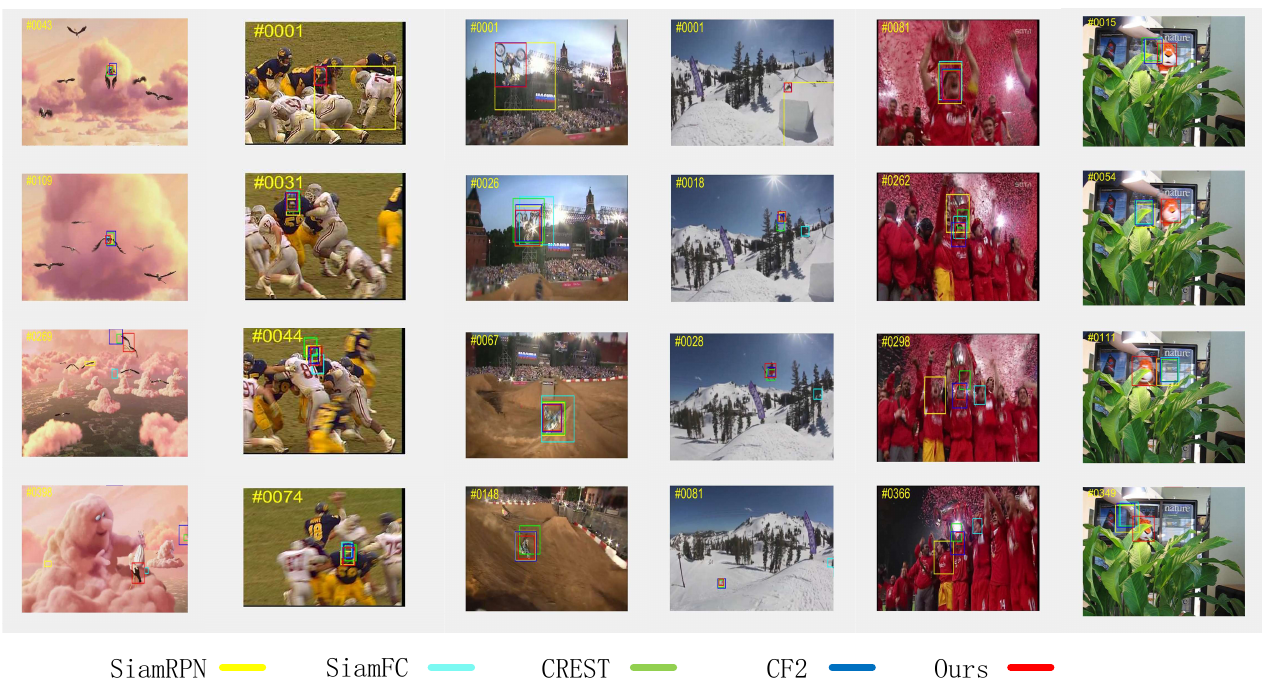
Figure 9. Visualization of tracking results for focused challenge